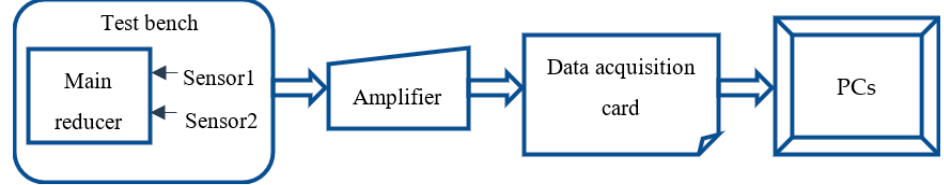
Figure 6. The process of data acquisition.